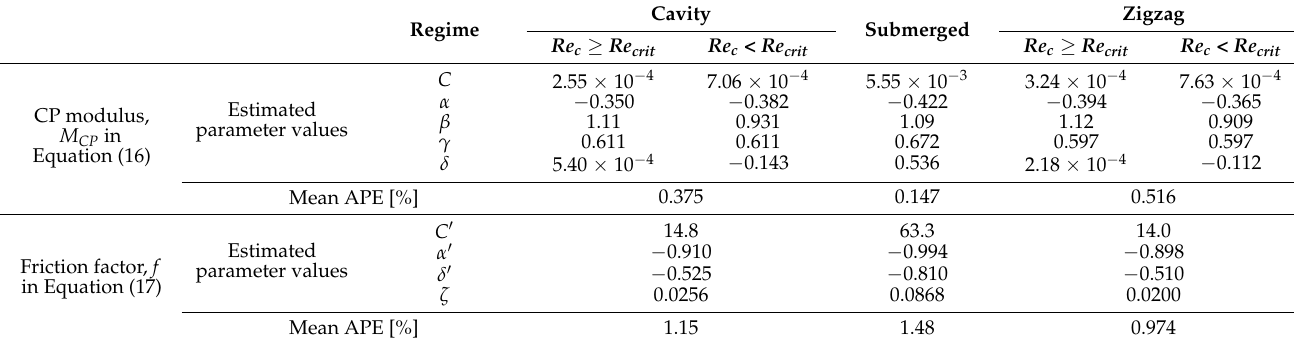
Table 3. Estimated parameter values for CP modulus and pressure drop correlations in three configurations and APEs of the correlations compared to the corresponding CFD